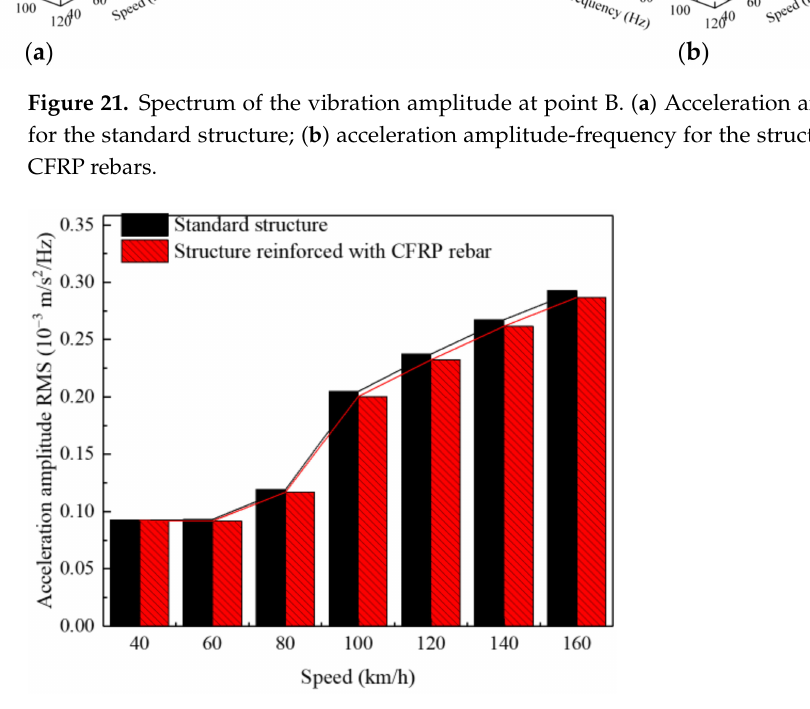
Figure 22. Acceleration amplitude RMS diagram at point